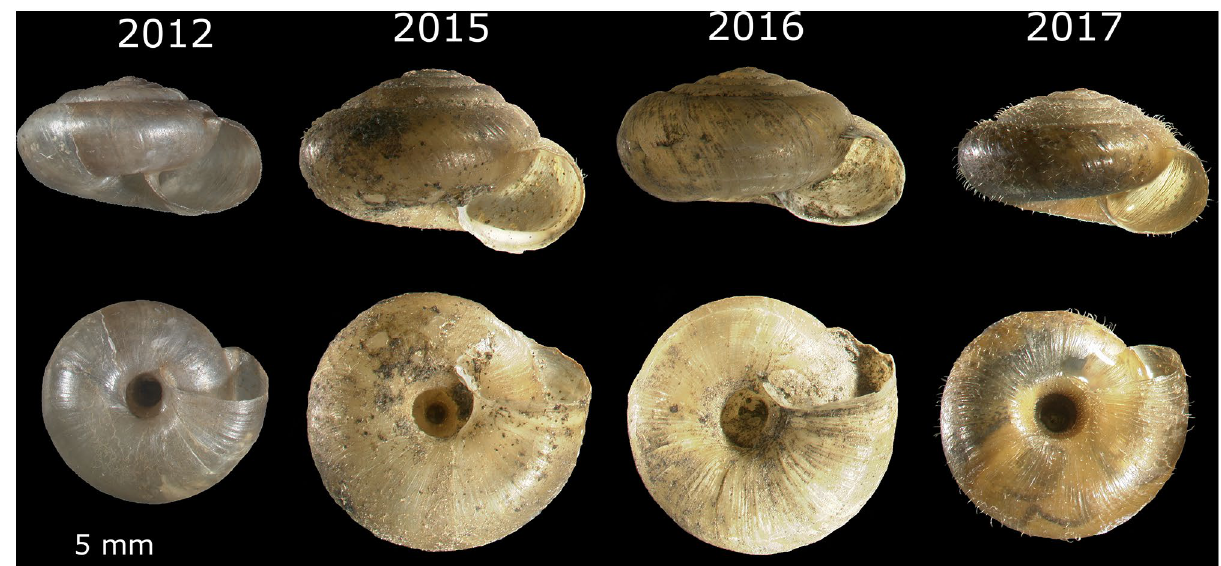
Figure 1. Shells of Trochulus hispidus collected in different years in